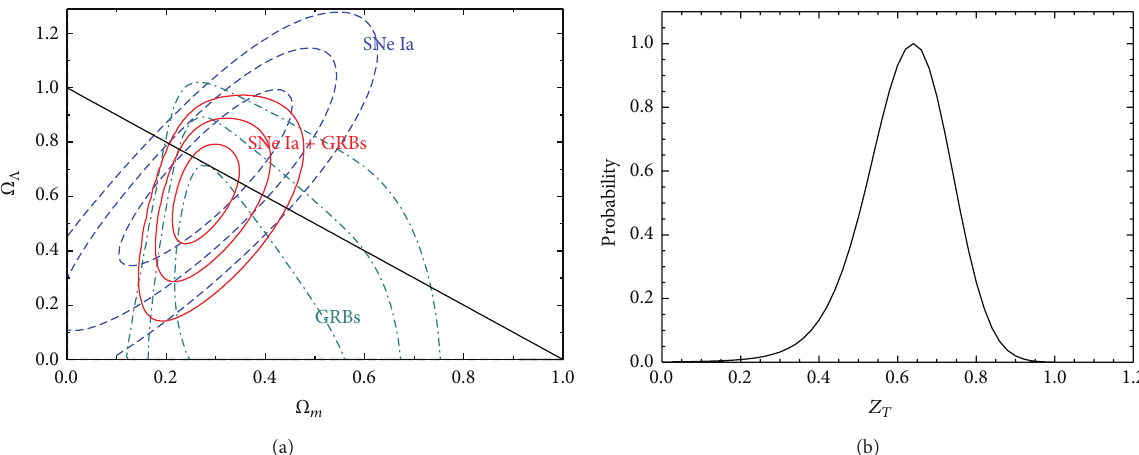
Figure 3: (a) The contour confidence levels of (Ω 𝑚 , Ω Λ ) in the Λ CDM model from the data for 82 GRBs ( 𝑧 > 1.4 ) (dark cyan dash-dotted lines), 580 SNe Ia (blue dashed lines), and 82 GRBs + 580 SNe Ia (red solid lines), respectively. The contours correspond to 1, 2, and 3𝜎 confidence regions. (b) The probability versus the transition redshift derived from the GRB and SNe Ia sample.